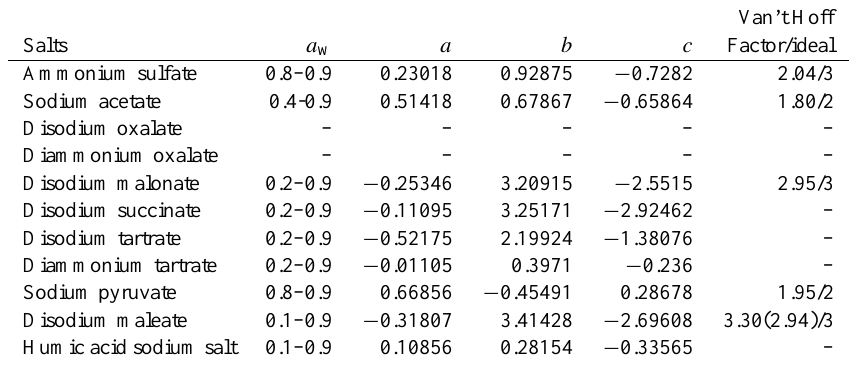
Table 2. The fitting parameters of the growth curve parametrization and Van’t Hoff